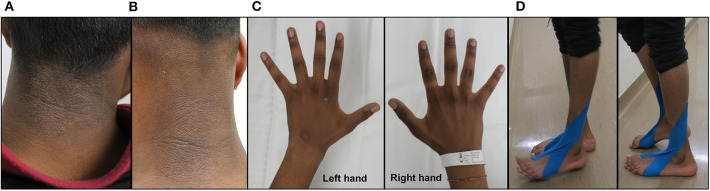
Clinical examination. Eczematous skin rash on the neck prior to biotin supplementation (A) and 4 months after biotin supplementation (10 mg/d b.i.d.) (B). Demonstration of muscle wasting of the interossei muscles of the right and left hands prior to biotin supplementation (C). Clinical examination of the individual prior to biotin supplementation showing difficulties in heels (left panel) to toes walking (right panel) (D).